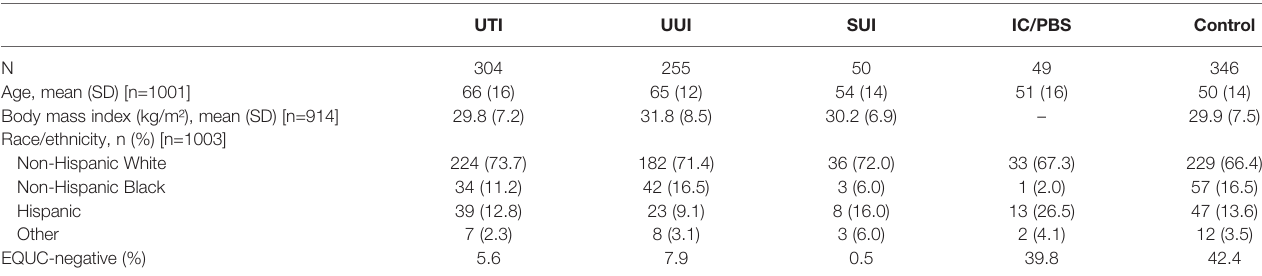
TABLE 1 | Participant characteristics.